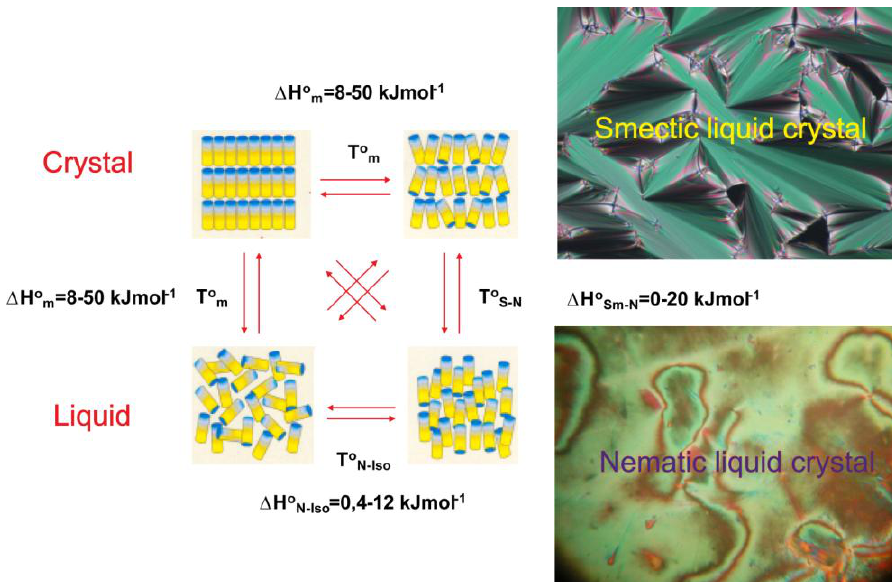
Figure 1. Phase transitions in mesogenic molecules and observed texture under polarization microscope for the SmA phase and N phase as an example. The observed range of value for the enthalpy changes during transitions is also given.